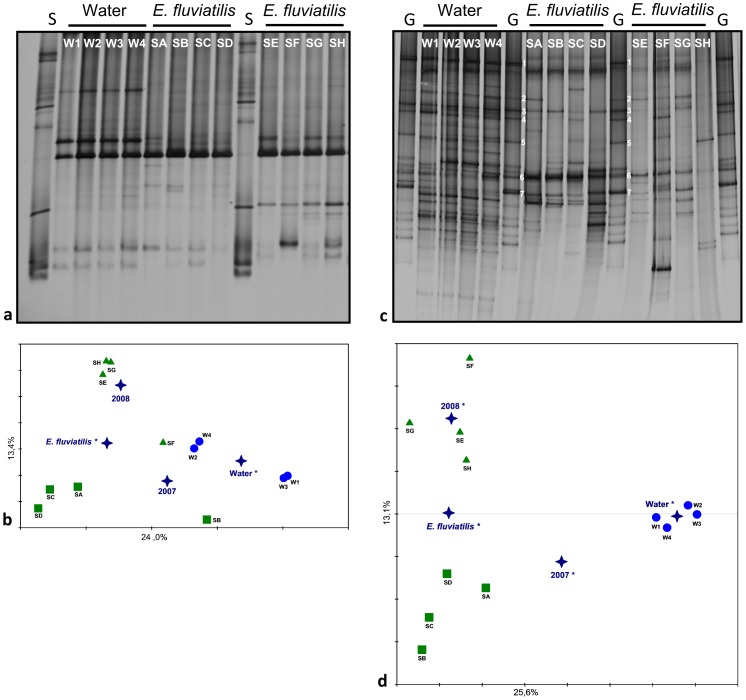
PCR-DGGE fingerprints.
Pseudomonas 16S rRNA (a) and gacA (c) gene fragments amplified from Ephydatia fluviatilis (2007: SA-SD and 2008: SE-SH) and lake water (2007: W1–W4) and their respective ordination diagrams generated by redundancy analysis (b, d) are shown. 16S rRNA (S) and gacA (G) gene standards were applied on the corresponding gels to control the DGGE run (see methods for standard compositions). Numbers 1 to 7 show some of the PCR-DGGE gacA gene bands amplified from E. fluviatilis metagenomic DNA (cultivation-independent approach) that matched gacA gene electrophoretic mobilities from E. fluviatilis-derived Pseudomonas isolates (cultivation-dependent approach). In ordination diagrams, green squares and triangles correspond to E. fluviatilis samples from 2007 and 2008, respectively; and blue circles to lake water samples. Blue stars: centroid positions of the independent variables E. Fluviatilis, lake water and year of sampling. Independent variables found to significantly influence PCR-DGGE band profiling variation are marked with an asterisk.